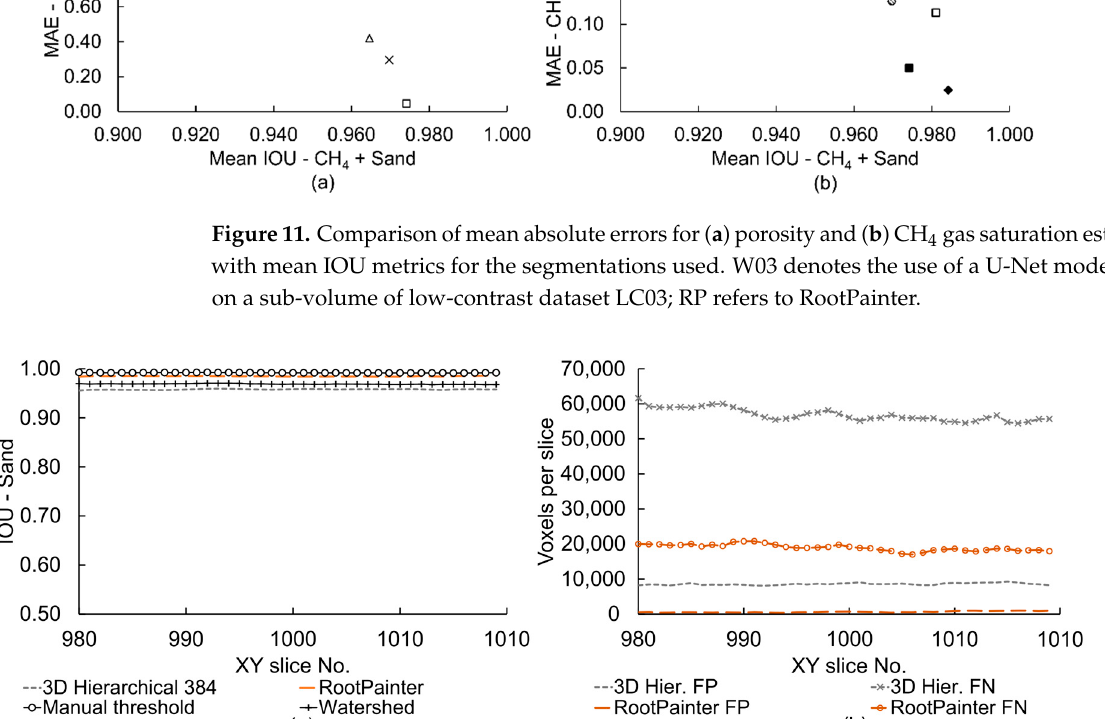
Figure 12. ( a ) IOU metrics for the segmentation of sand in dataset IC01 using the 3D hierarchical method (3D training/validation sub-volume) and RootPainter, and ( b ) associated false positive (FP) and false negative (FN) sand voxels per slice of the central 40 XY slices. Metrics for the manual thresholding and watershed methods included in ( a ) for